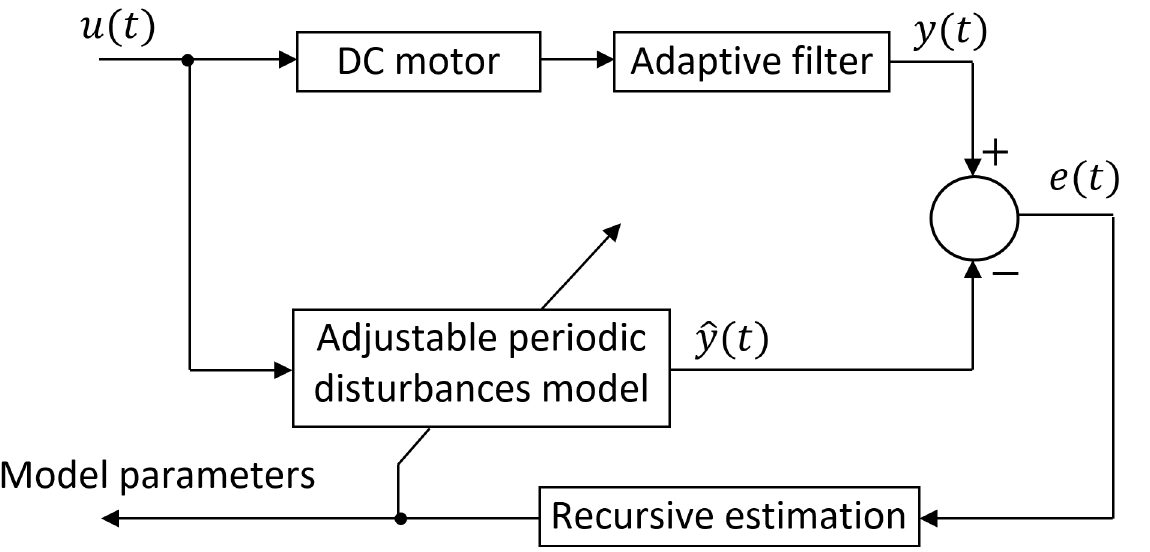
Fig 11. Principle of model parameters